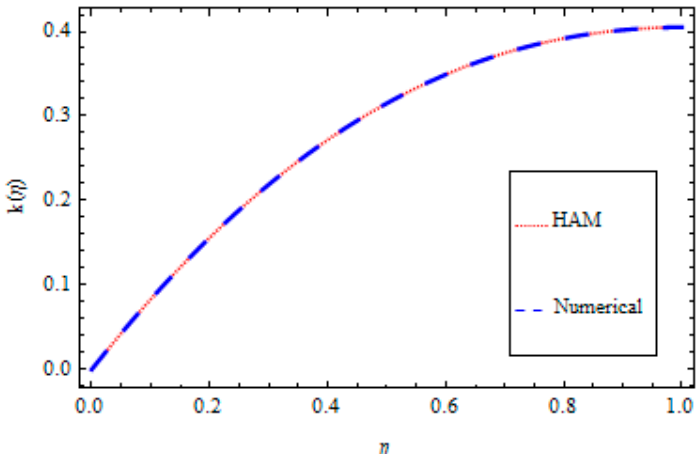
Figure 3. Graphical comparison of the HAM and numerical solution. Table 3. Comparisons of the HAM and numerical solution.